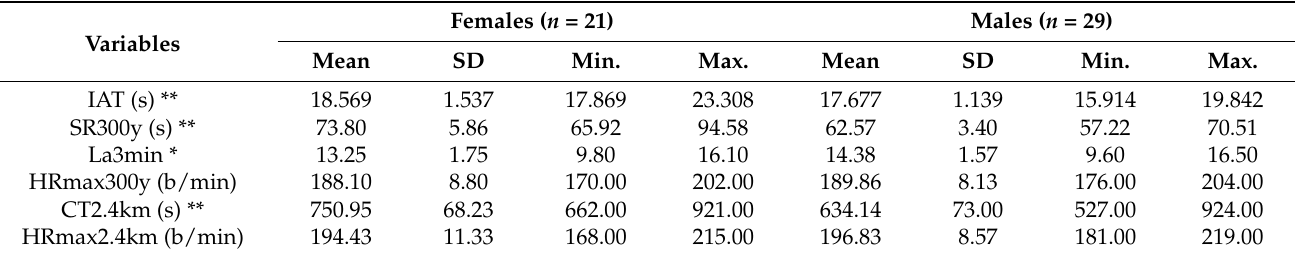
Table 1. Descriptive characteristics of the study participants and differences between sexes.